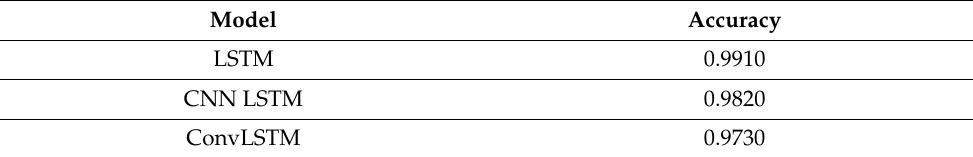
Table 3. Accuracy results from all tested deep-learning architectures.